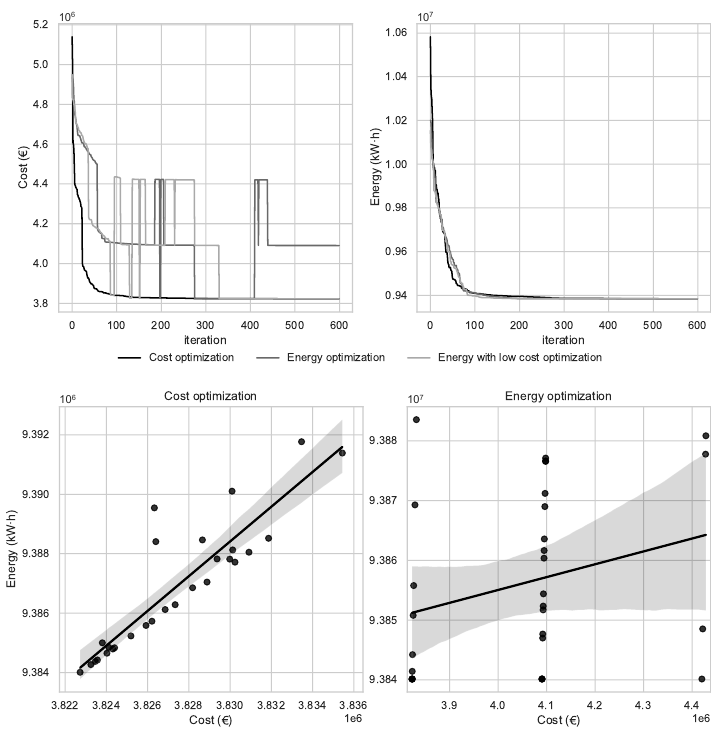
Figure 6. Optimization results from both cost and energy optimization